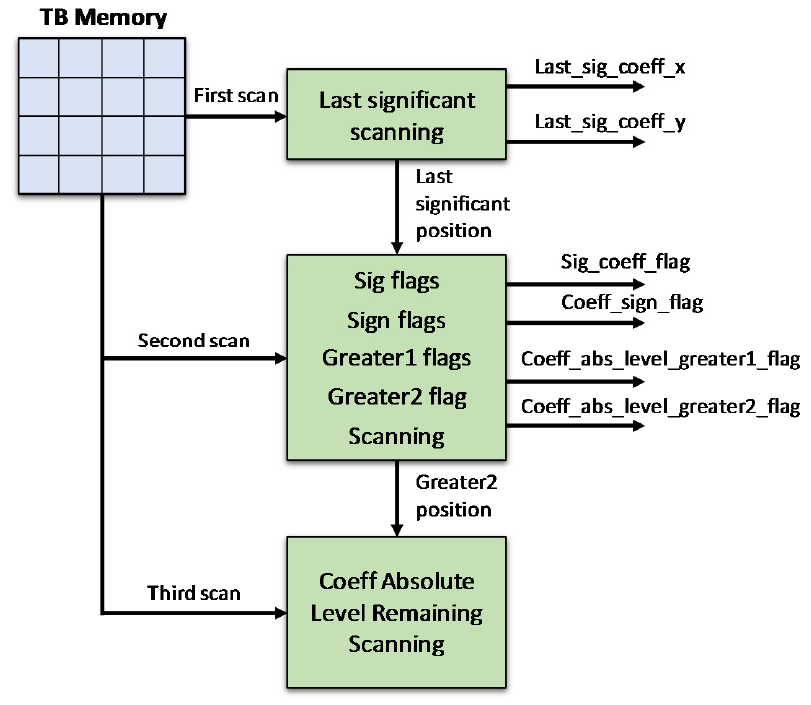
Figure 6. Scanning and SE generation architecture.